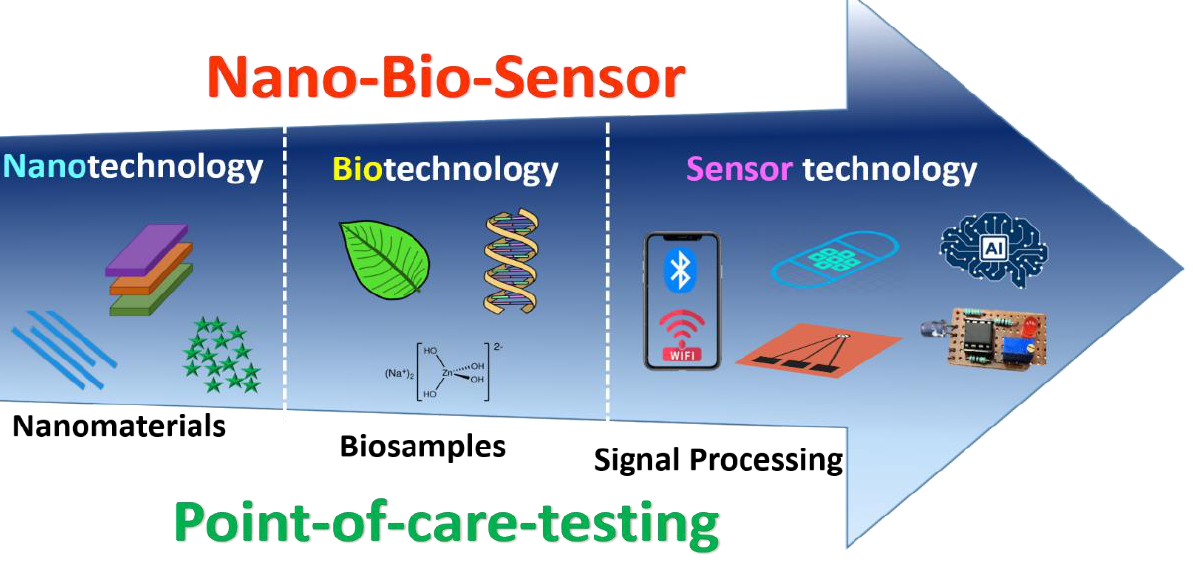
Figure 10. Future scope of nanobiosensors.